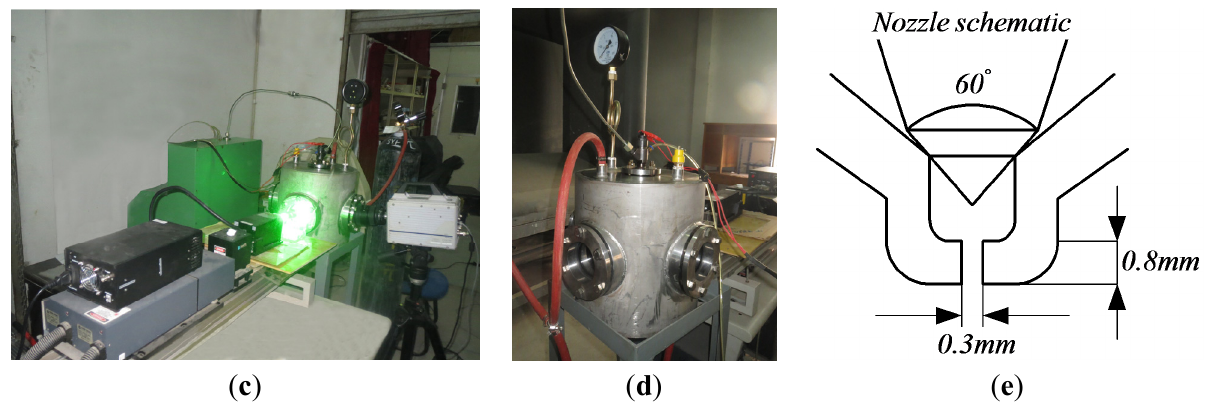
Figure 1. ( a ) schematic of the spray visualization system; ( b ) the definitions of spray tip penetration and spray angle; ( c ) setup of the high speed imaging system; ( d ) the constant volume chamber; ( e ) schematic of the mini-sac nozzle.